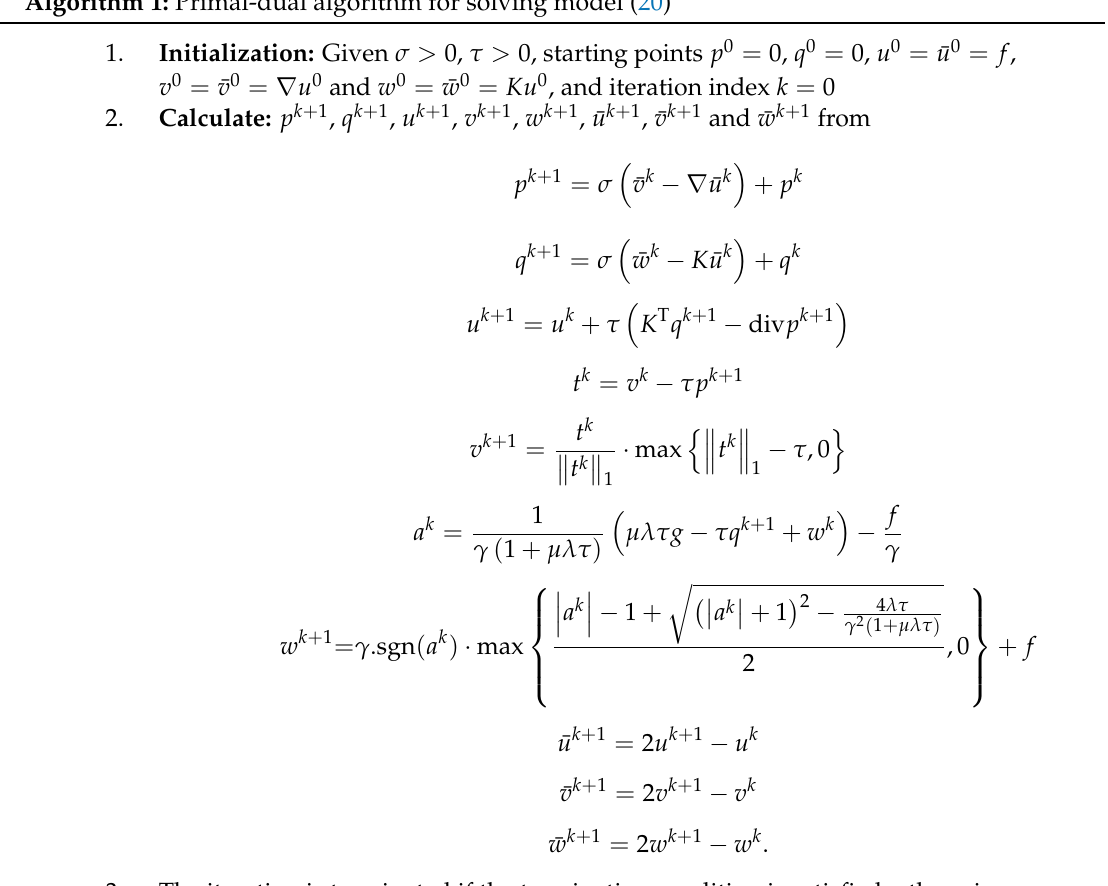
Algorithm 1: Primal-dual algorithm for solving model